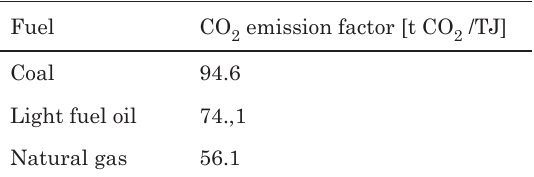
emission factors for different fuels table 2. co 2